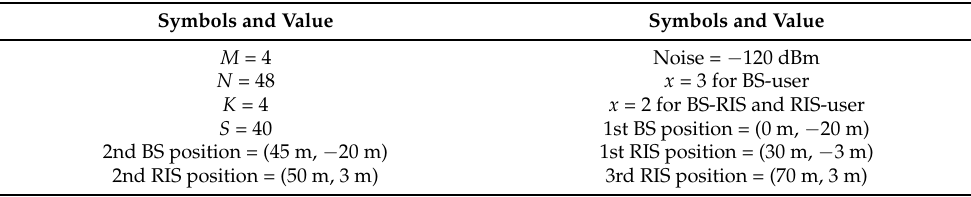
Table 3. A summary of simulation parameters. Symbols and Value Symbols and